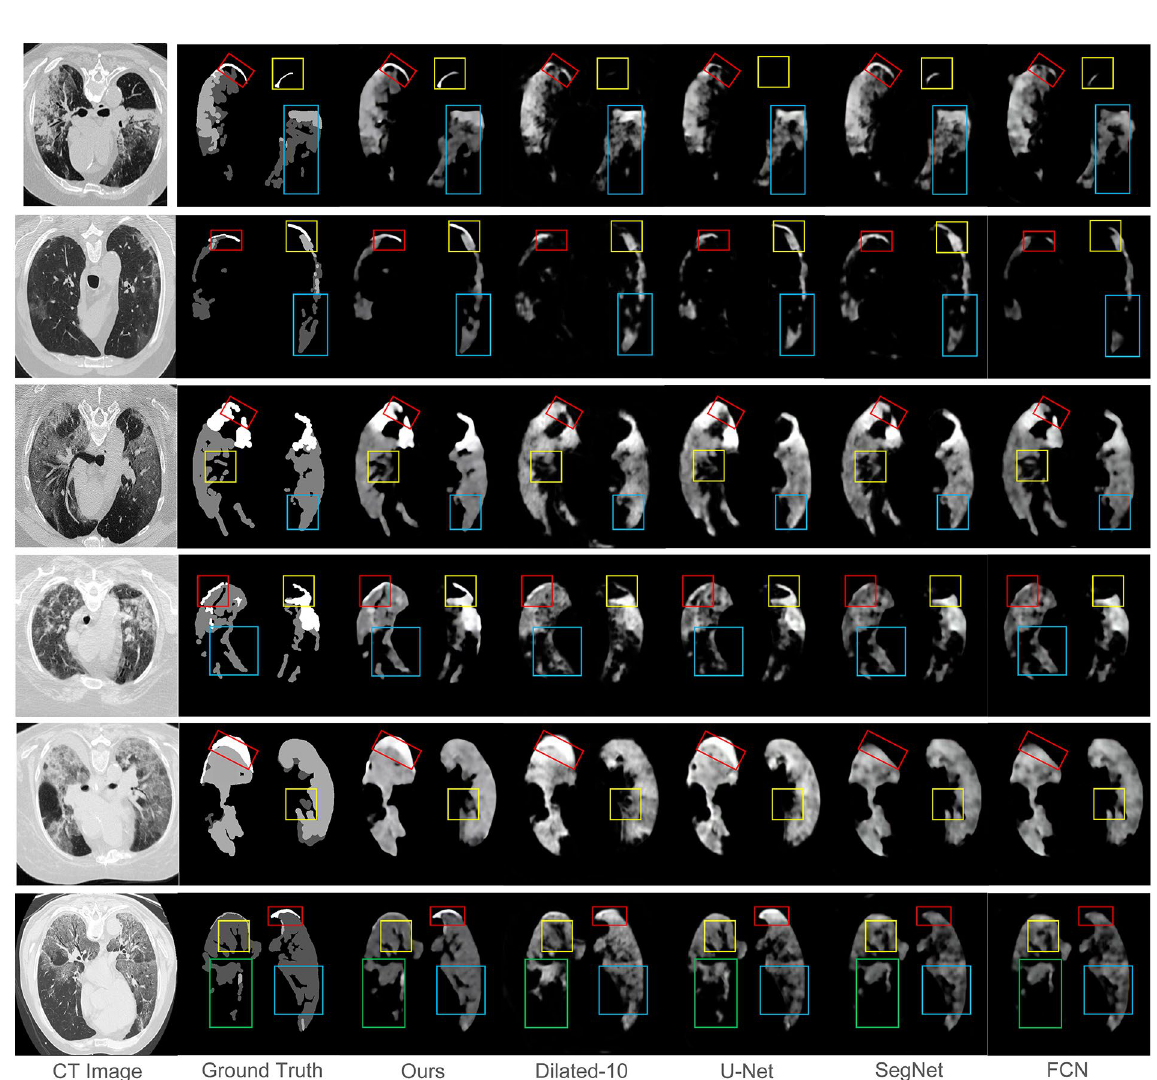
Figure 9. Segmentation results of different scale lesions, where the dark gray, bright gray, and white labels indicate the ground-glass, consolidation, and pleural effusion,